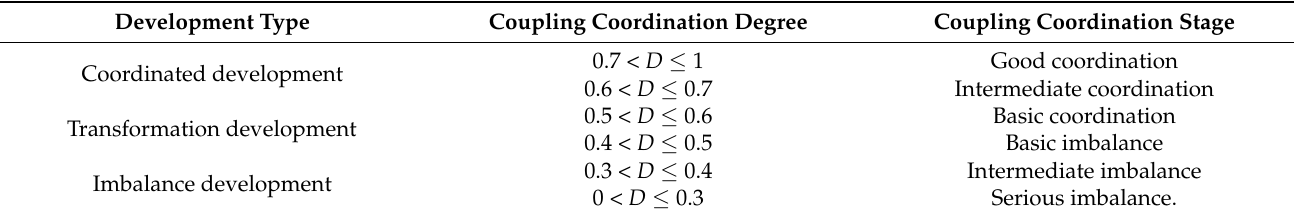
Table 2. Type division of coupling coordinated